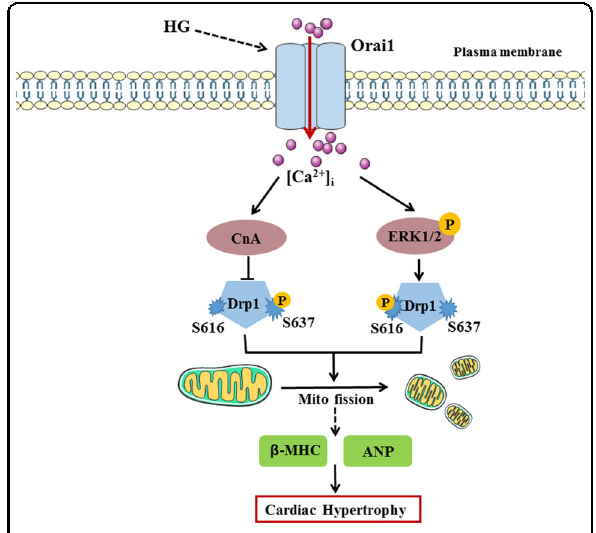
Fig. 8 Schematic diagram depicting proposed Orai1 – Drp1 signaling pathway in cardiomyocyte hypertrophy induced by HG. HG stimulation induces upregulation of Orai1. Then, Orai1-mediated Ca 2 + entry targets CnA to inhibit Drp1 phosphorylation at S637, inducing cardiac hypertrophy. Orai1- mediated Ca 2 + entry also targets p-ERK1/2 to induce Drp1 phosphorylation at S616. Phosphorylation of Drp1 at S616 is increased, while phosphorylation of Drp1 at S637 is decreased, promoting mitochondrial fi ssion and accelerating HG-induced cardiac hypertrophy. Inhibition of the Orai1 – Drp1 signaling pathway could prevent cardiac hypertrophy induced by